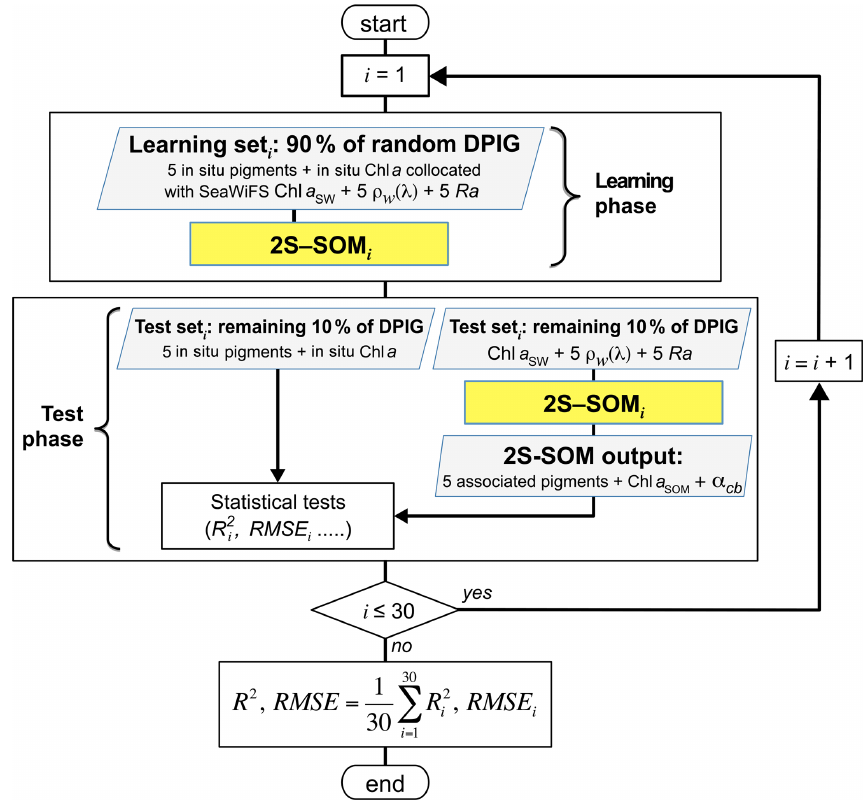
Figure 5. Flowchart of the cross-validation procedure for 30 partitions of the DPIG